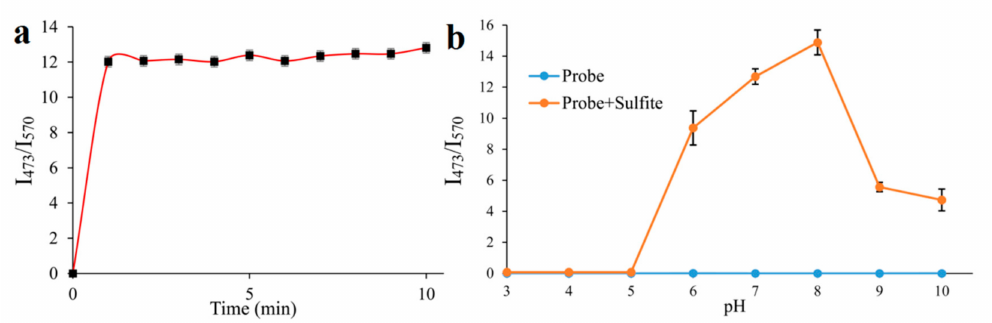
Figure 3. ( a ): E ff ect of time on the I 473 / I 570 fluorescence intensity ratio of probe EB (10 µ M) in PBS solution (pH = 7.4) upon addition of 500 µ M SO 32 − ; ( b ): E ff ect of pH on the I 473 / I 570 fluorescence intensity ratio of probe EB (10 µ M) and probe EB upon addition of 500 µ M SO 32 − .